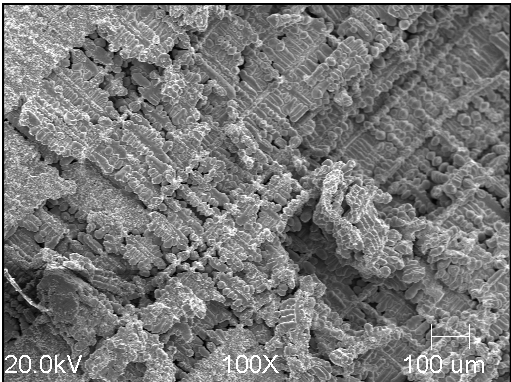
Figure 9. Fracture of reference sample (SEM; magnification—100×).